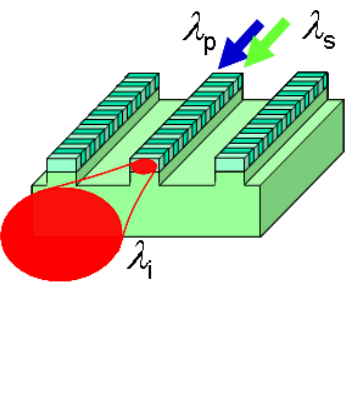
Figure 1. Structure of QPM-LN waveguide